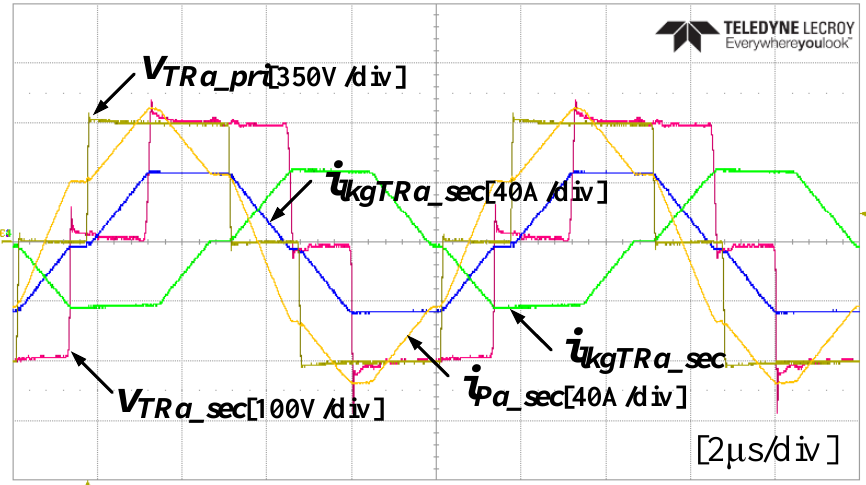
Figure 17. Hardware configuration of 3P-CFDAB converter.